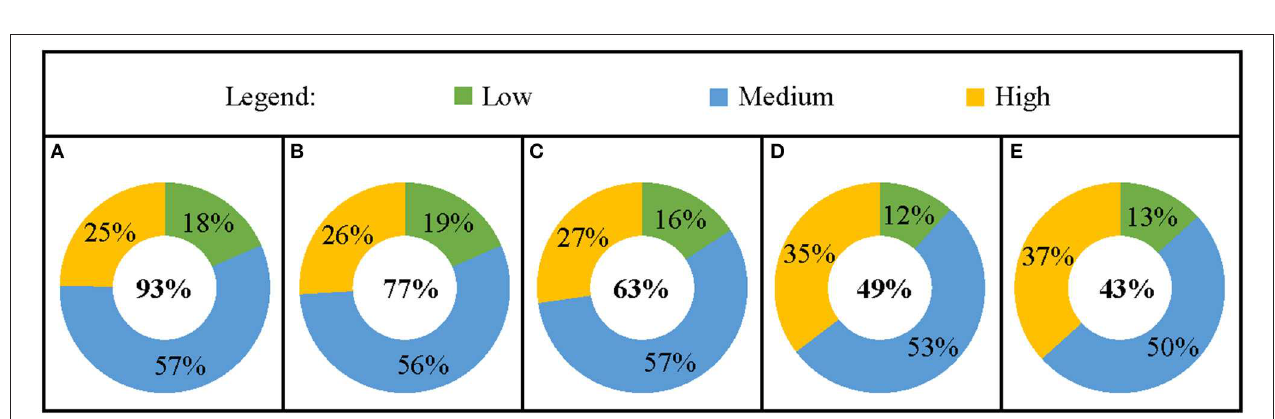
FIGURE 8 | Consumer rational for eating lentils. Total percentage (center), and proportion of low, medium, and high lentil consumption groups that reported their rationale for eating lentils based on (A) nutritional properties, (B) affordability, and to support (C) a plant-based diet, (D) the environment, and (E) local farmers ( n = 70).